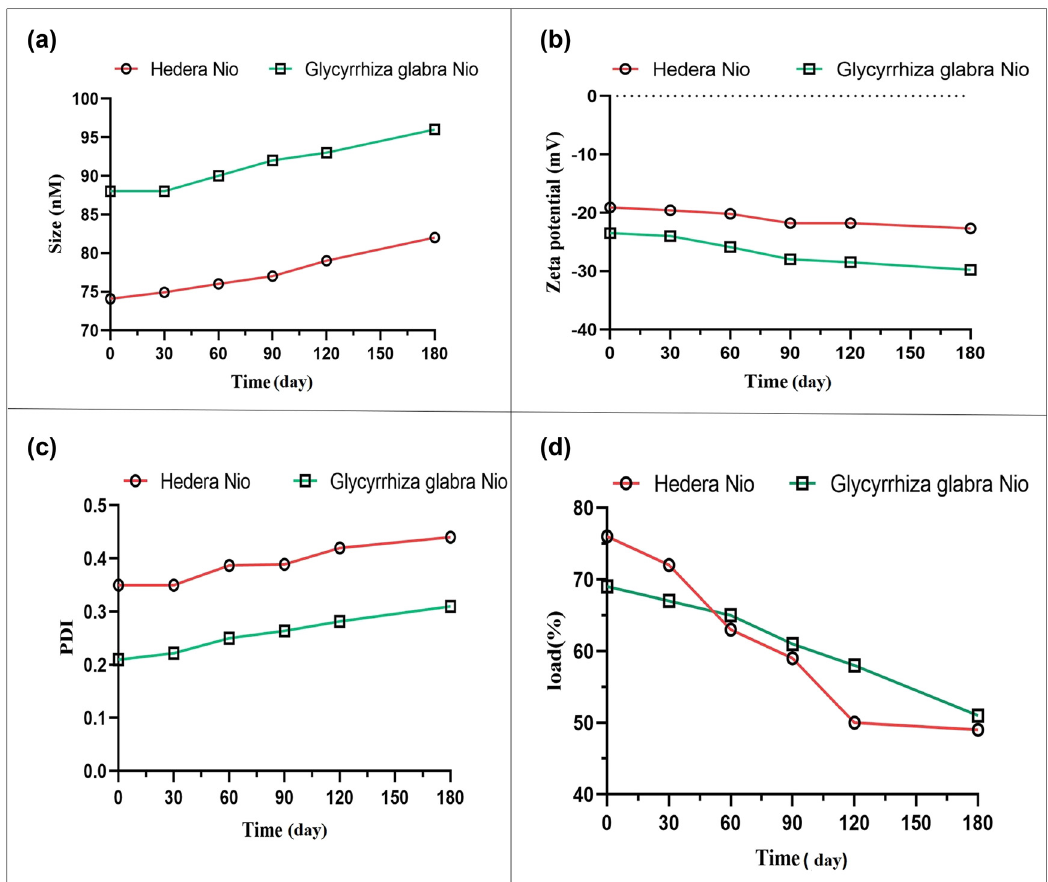
Figure 6: The stability analysis of Nio - GGE and Nio - HHE: ( a ) in terms of size; ( b ) zeta potential; ( c ) PDI; and ( d ) drug leakage over 180 days storage at −